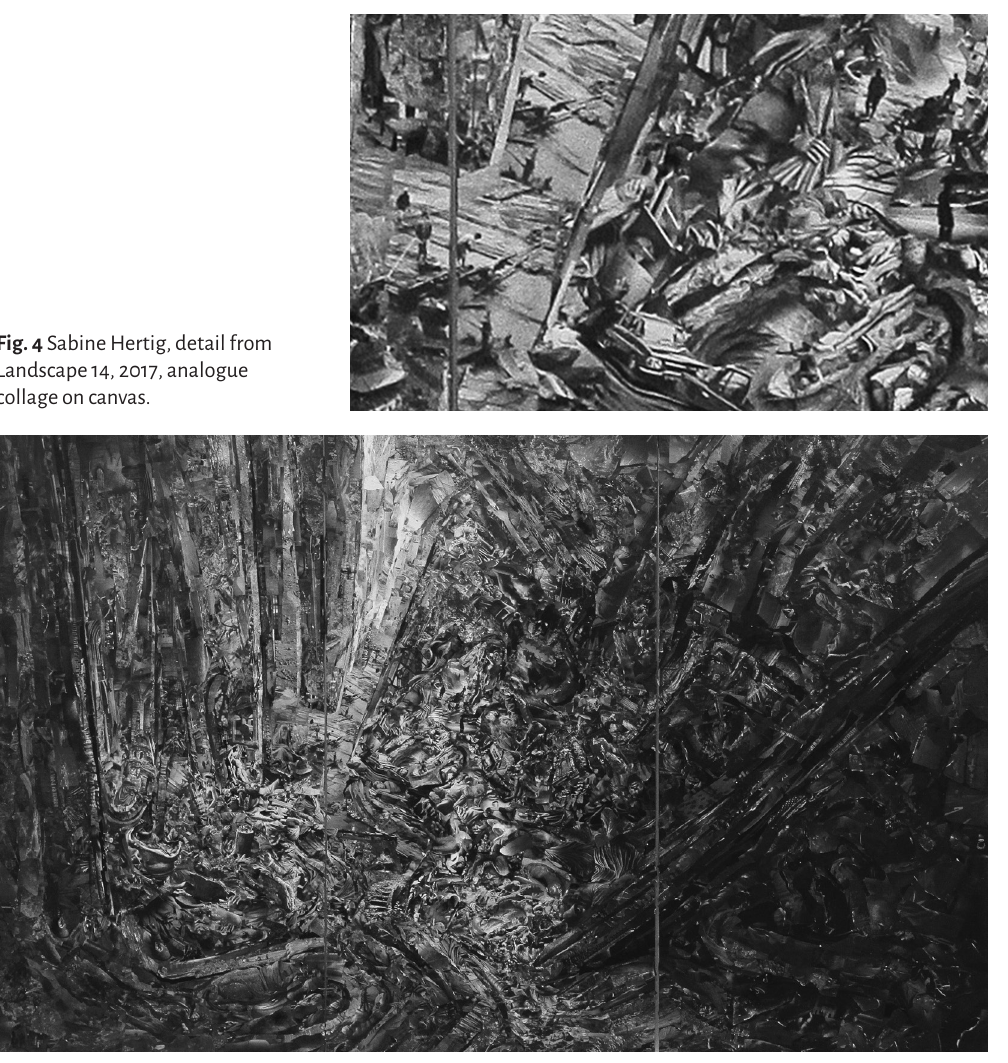
Fig. 5 Sabine Hertig, Landscape 14 , analogue collage on canvas, three vertical sections, overall dimensions 300 x 465, 2017.